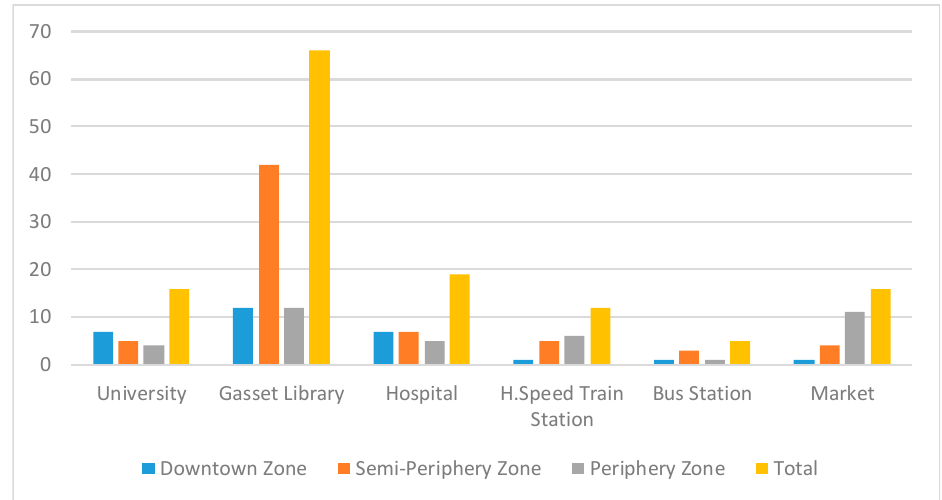
Figure 6. Results of answers related to leisure. Source: Own work.